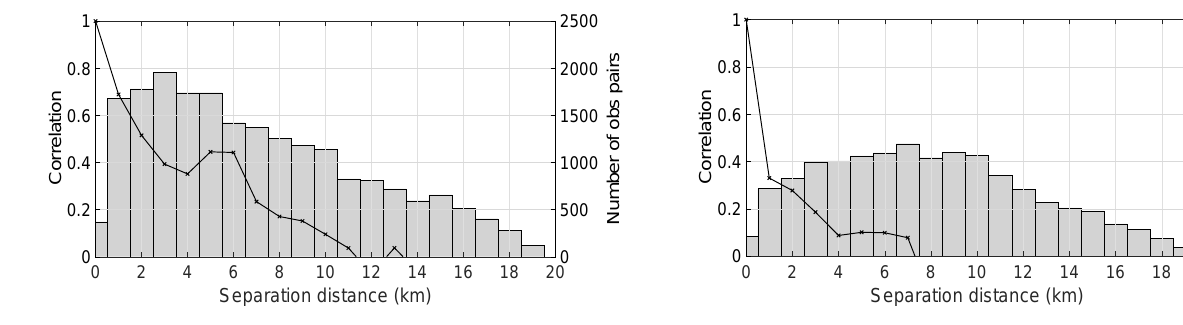
Figure 6. Estimated SAR WLO error correlations (black line) and number of samples (bars) used (bin width = 1km), 30 November and 1 December. Estimated error standard deviation is 43cm.